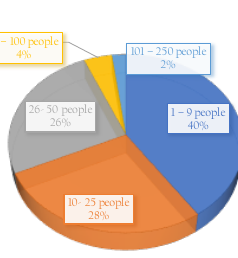
Figure 1. Field of activity of companies which completed the survey. The FinTech sector in Poland is still a relatively young one—15% of our respondents were still under development (i.e., in a testing phase). The majority of our respondents were present on the market for 5 to 10 years (44% of the firms) or for 1 to 5 years (35%). The “mature” companies running their business from 10 to 15 years represent the lowest share (6%) in the group (see Figure 2, left panel).